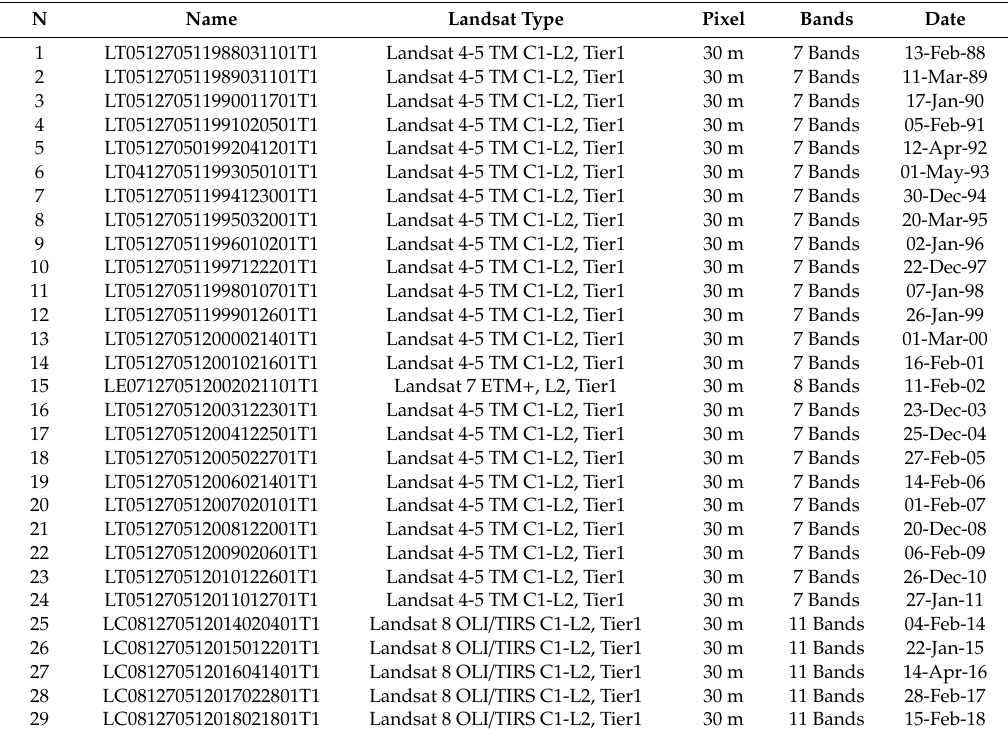
Table 1. Landsat data from 1988 to